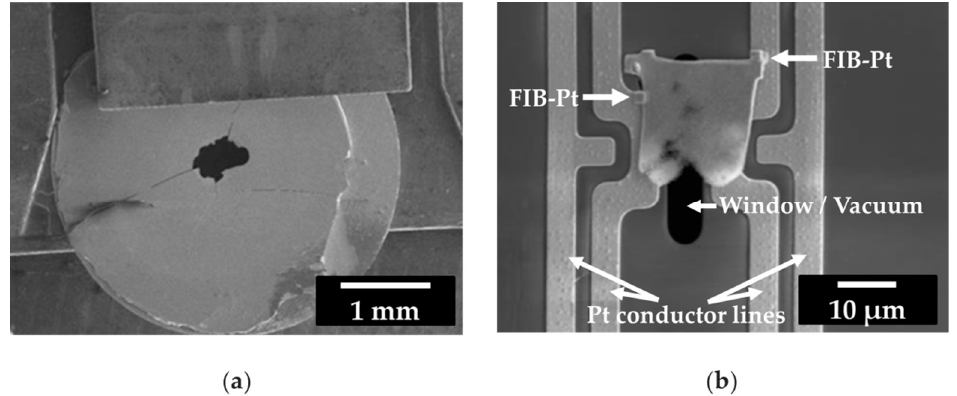
Figure 2. ZnO green body specimen. ( a ) Precision ion polishing system (PIPS) prepared disc-shaped sample, and ( b ) the focused ion beam (FIB) mounted lamella, which was cut from the edge area of the PIPS generated hole in ( a ). The FIB-Pt patches, indicated with arrows, attach the ZnO lamella to the SiN membrane and Pt conductor lines of the DENSsolutions biasing-heating chip.